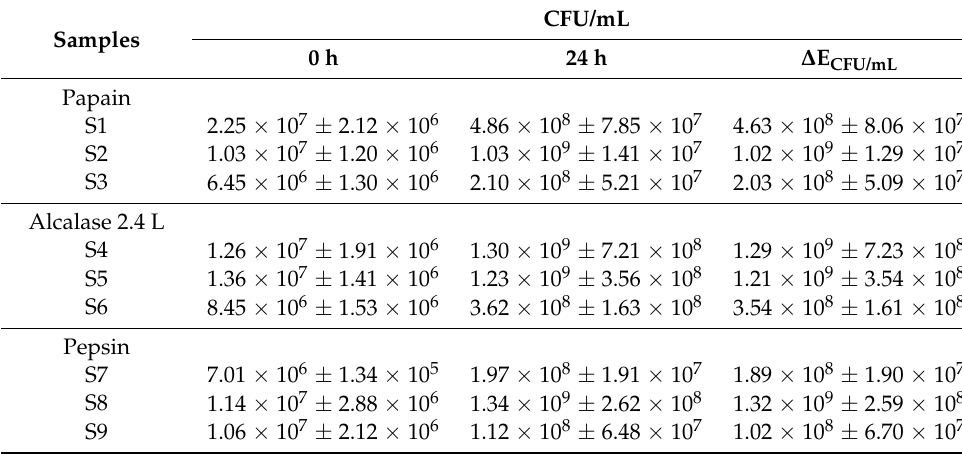
Table 4. Colony forming units (CFU) after 0 h and 24 h of fermentation.